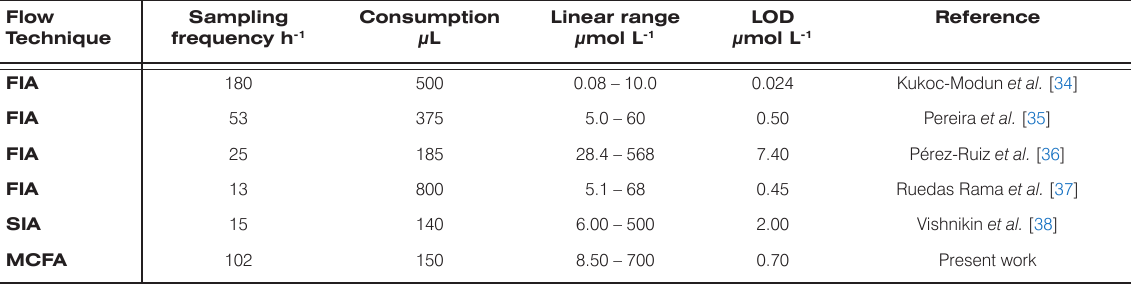
Table 2. Comparison between reported flow methods for AA determination and the proposed method. Flow Technique